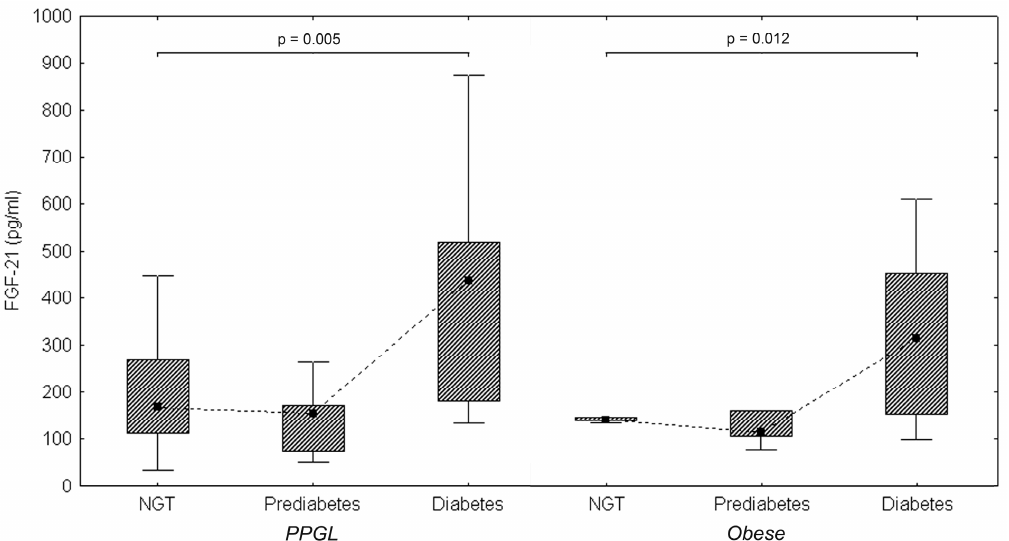
Figure 2. FGF21 levels in obese and PPGL with normal glucose tolerance (NGT), prediabetes, and diabetes mellitus.